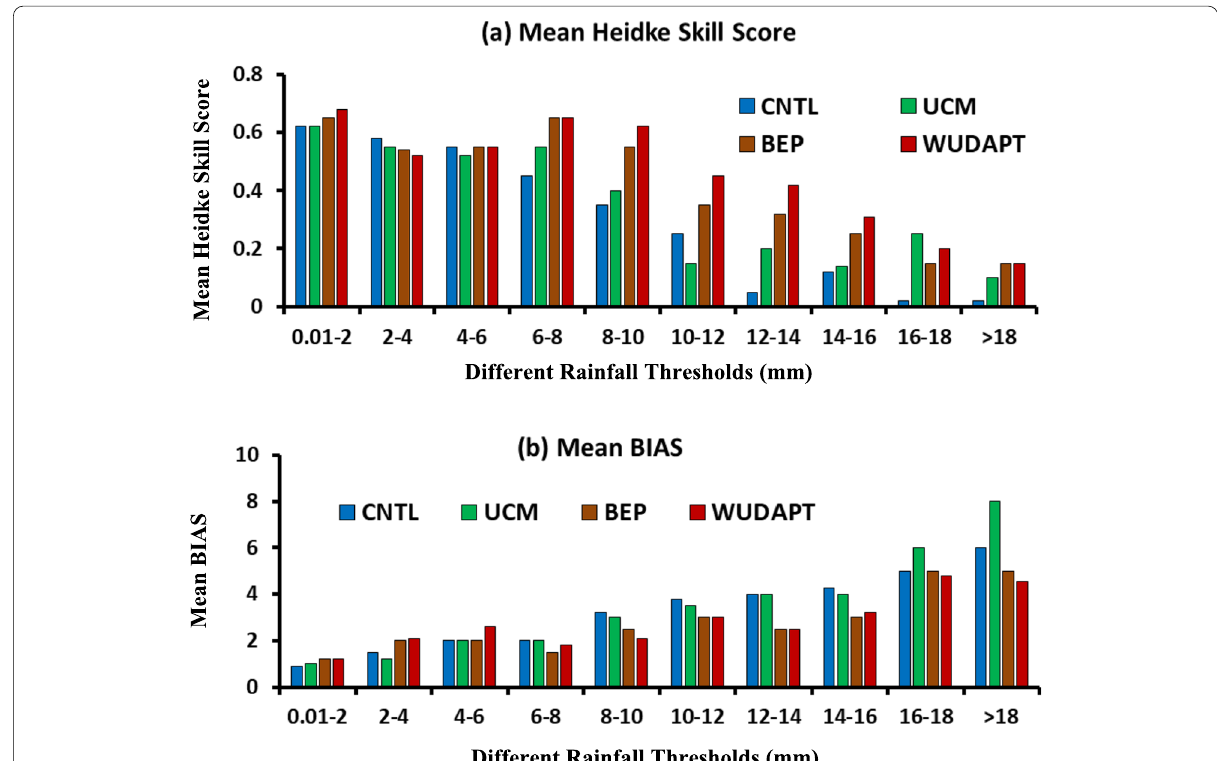
Fig. 6 Same as Fig. 4 but for Rainfall